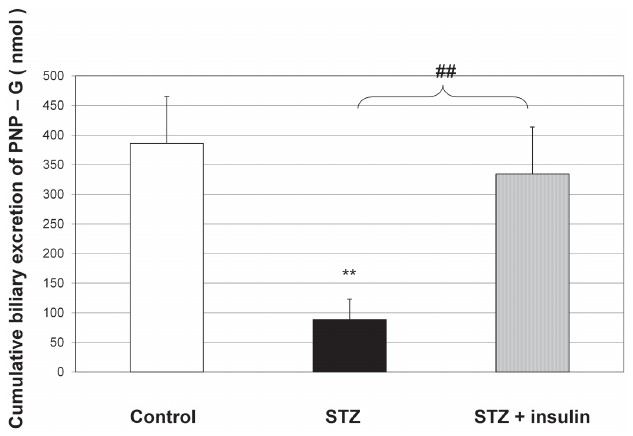
FIGURE 1 - Cumulative biliary excretion of PNP-G after the 90-min luminal perfusion of 500 µM PNP in control and diabetic rats without or with insulin administration. Data represent the mean of ± S.E. of seven rats. Significant difference from the control value: ** p<0.01. Significant difference from the value of STZ-diabetic rats without insulin administration: ##